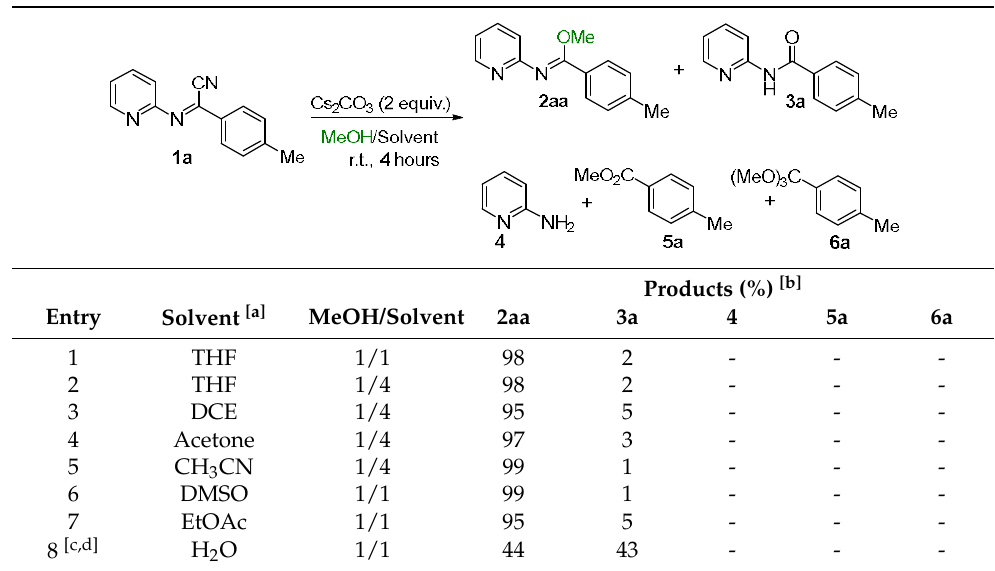
Table 2. Reaction evaluation using different co-solvents for the transformation of 1a to 2aa in the presence of MeOH.